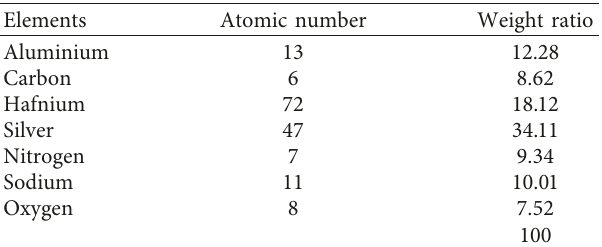
Table 3: EDX analysis for the elemental percentage contents of biosynthesized AgNPs from M. parviflora leaves